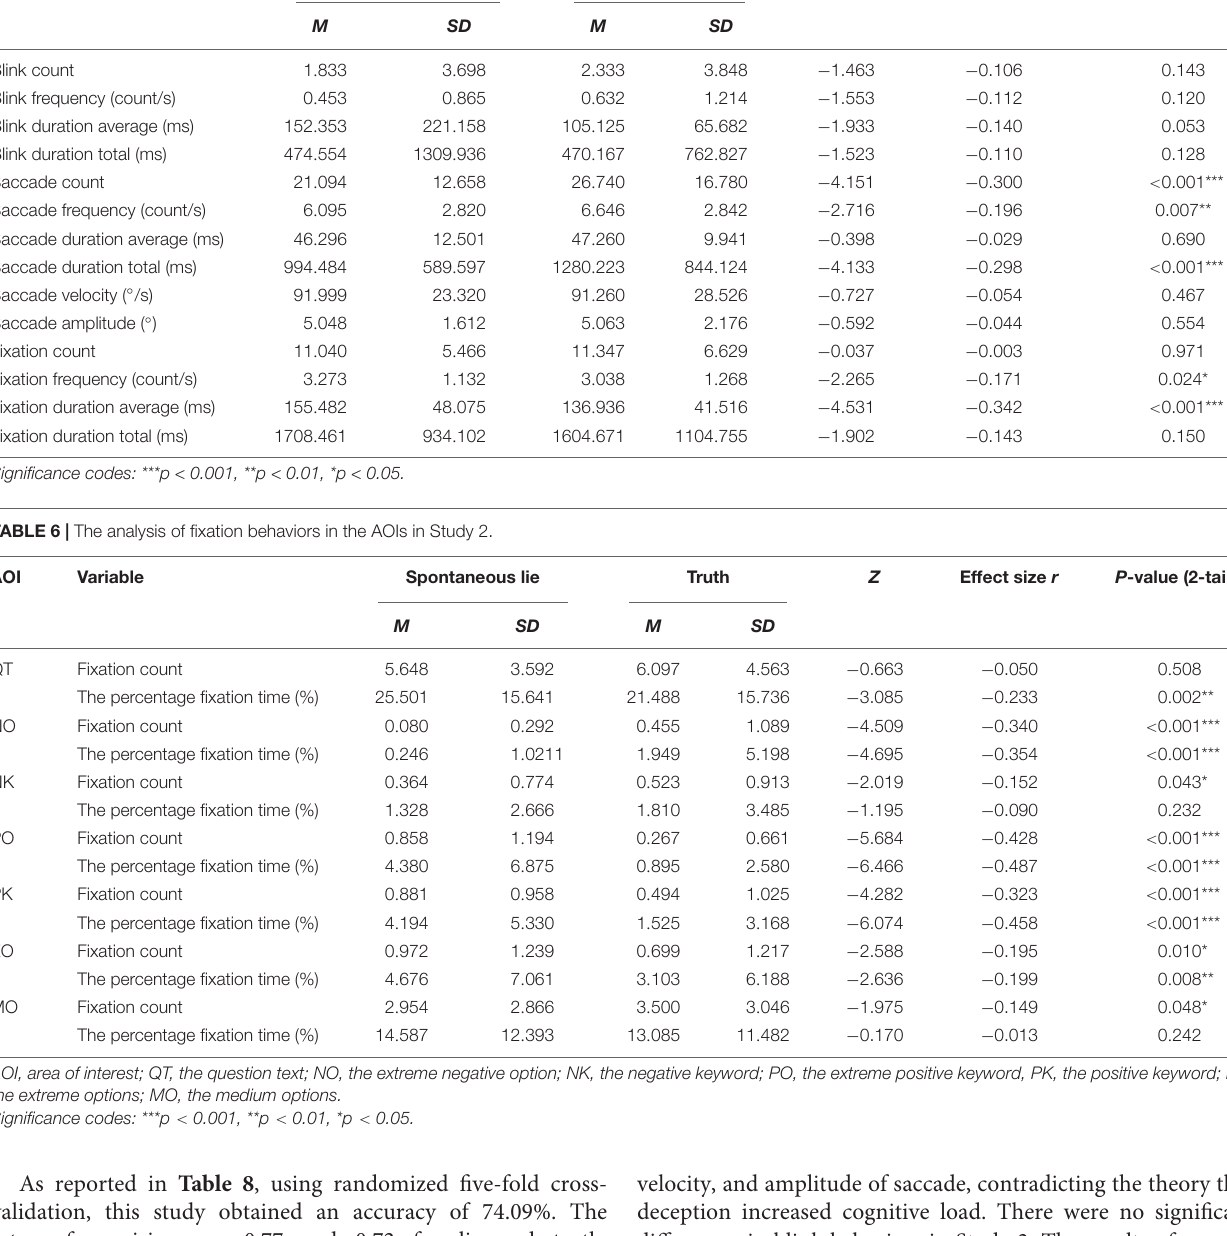
TABLE 5 | The analysis of blink behaviors, saccade behaviors and fixation behaviors in Study 2. Variable